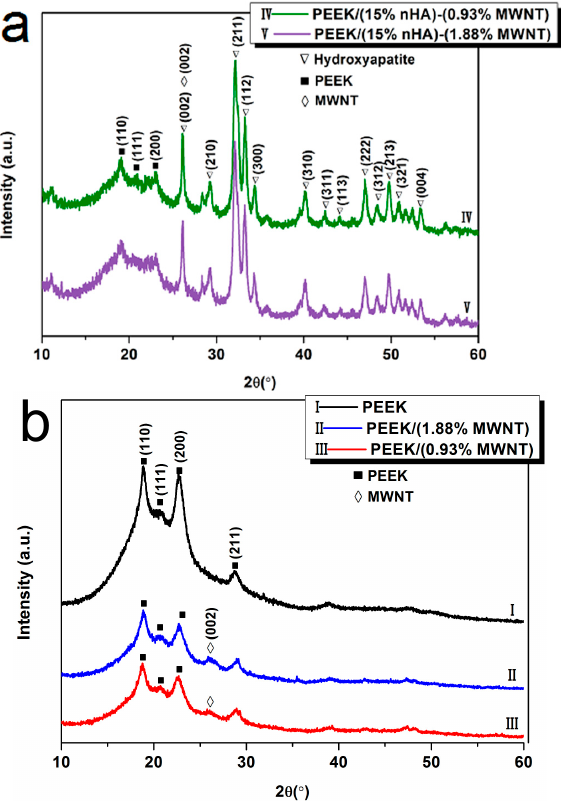
Figure 2. X-ray diffraction (XRD) patterns of ( a ) PEEK/(15% nHA)-(0.93% MWNT) and PEEK/(15% nHA)-(1.88% MWNT) hybrids and ( b ) pure PEEK and PEEK/MWNT nanocomposites.